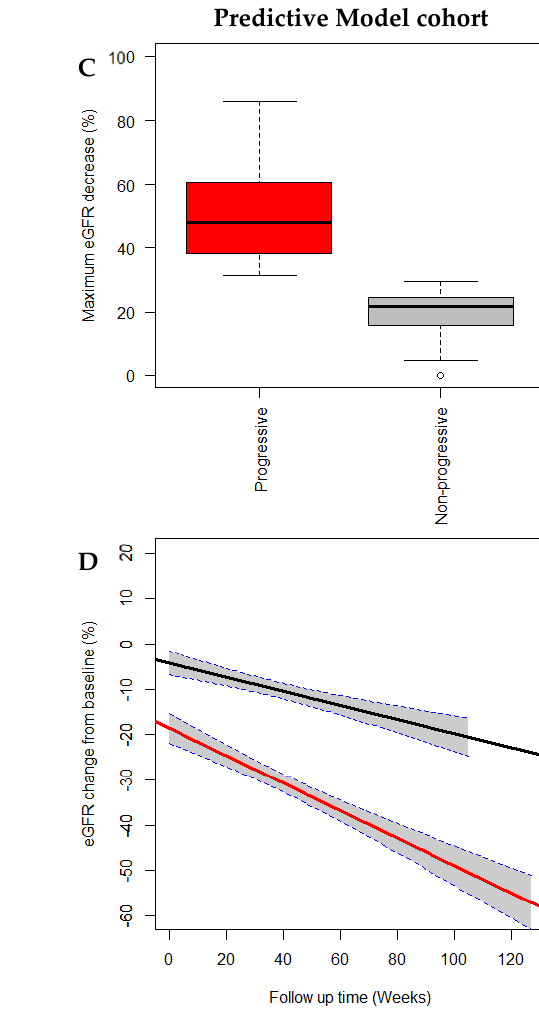
Figure 1. CKD patients of the Biomarker Discovery ( A , B ) and the Predictive Model ( C , D ) cohorts were classified as progressive (red) or non-progressive (grey/black) based on a composite outcome of a ≥ 30% decline in eGFR from baseline, initiation of dialysis, or kidney transplantation. This definition distinctly classified CKD patients as progressive and non-progressive. Progressive patients demonstrated a larger maximum eGFR decrease (%) from baseline compared to non-progressive patients ( A , C ). Progressive patients of the Biomarker Discovery cohort demonstrated a negative trajectory for eGFR percentage change from the baseline, which differed significantly ( p < 0.0001) from non-progressive patients who demonstrated a positive trajectory ( C ). Both progressive and non-progressive patients of the Predictive Model cohort demonstrated negative trajectories; however, these were significantly different from each other with progressive patients demonstrating a more negative trajectory ( D ). Abbreviations: Chronic kidney disease (CKD), estimated glomerular filtration rate (eGFR).